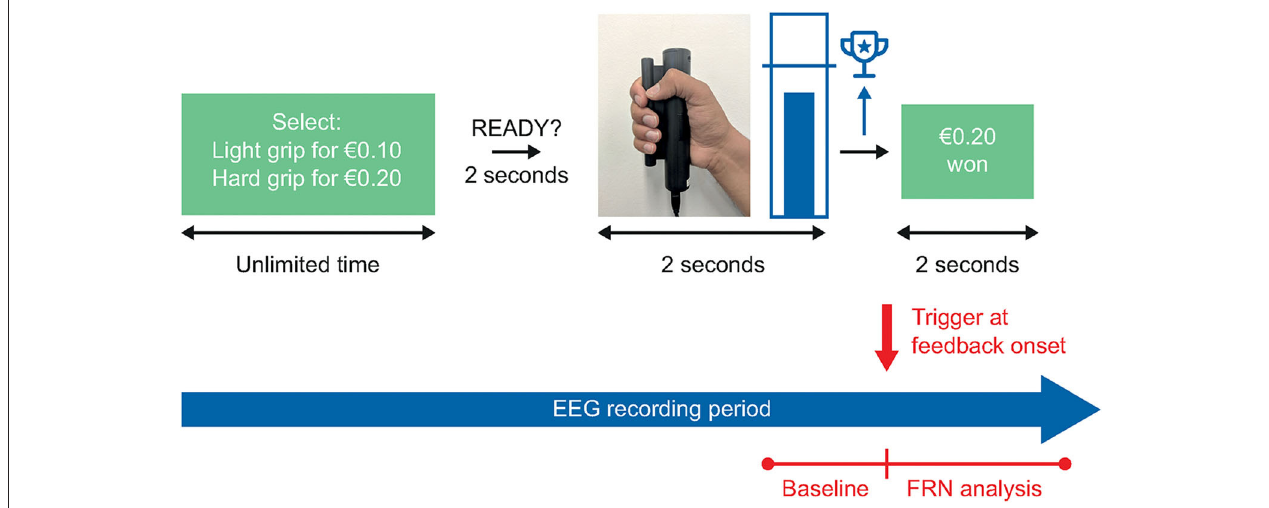
FIGURE 1 | The Grip Strength Effort task. In the Grip Strength Effort task, participants will complete 4 practice trials, 4 calibration trials, and 54 assessment trials, for a total task duration of approximately 20min. EEG, electroencephalography; FRN, feedback-related